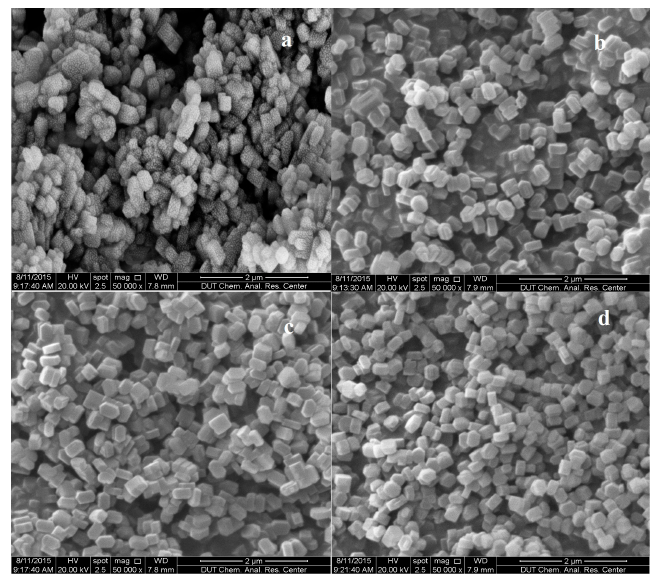
Figure 1. Scanning electron microscopy (SEM) images of defective MFI zeolites with different SiO 2 /Al 2 O 3 ratios. ( a ) HZ30, ( b ) HZ110, ( c ) HZ700, ( d ) S-1.